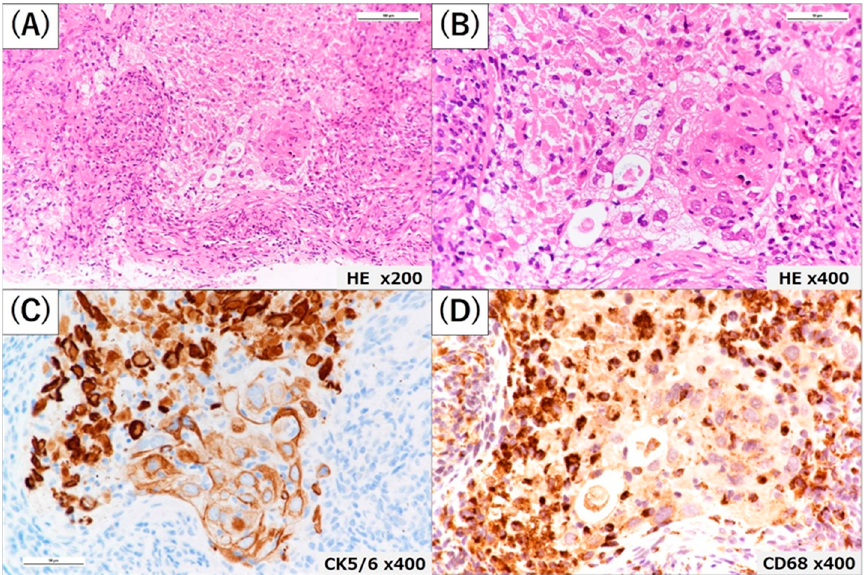
Figure 2. The histological examination of a percutaneous needle biopsy. At low power magni fi cation (Hematoxylin and Eosin staining, 100×), the tumor grows in an irregular geographic pa tt ern consisting of polygonal cells with brightly pink cytoplasm, and hyperchromatic and angular nuclei, and an area of necrosis in its upper can be seen ( A ). The pink cytoplasm with distinct cell borders and immature keratin pearls are seen at high magni fi cation (HE 400×) ( B ). Cells positive for CK5/6 by immunohistochemistry are shown not only in the tumor but also in the necrotic area (400×) ( C ). CD68-positive cells (macrophages) by immunohistochemistry are shown more abundant in the necrotic area than in the tumor and its stroma (400×) ( D ).